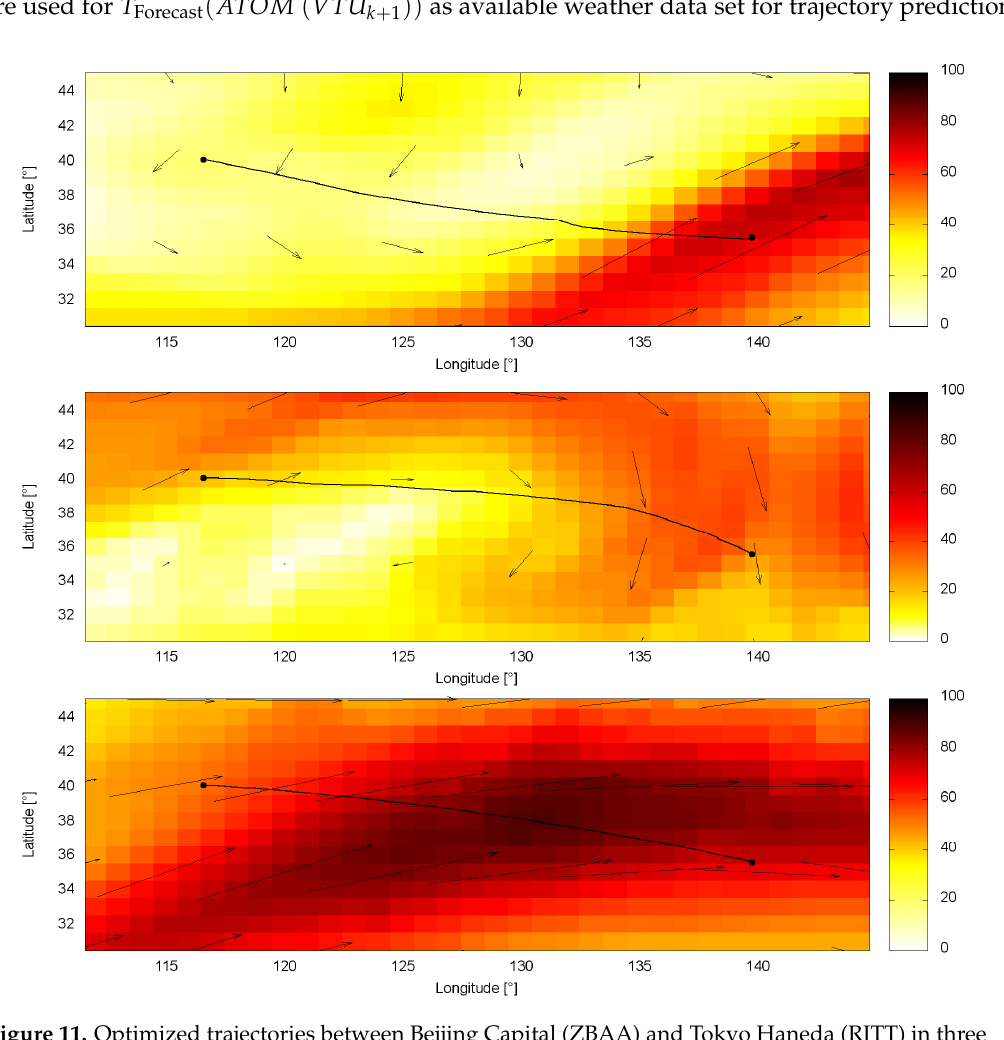
Figure 11. Optimized trajectories between Beijing Capital (ZBAA) and Tokyo Haneda (RJTT) in three different weather scenarios. Top : Scenario A on 25 th July 2016, middle : B on 17 th May 2017 and bottom : C on 29 th November, 2017. Colors indicate wind speed [m/s], arrows indicate wind direction, and wind speed.